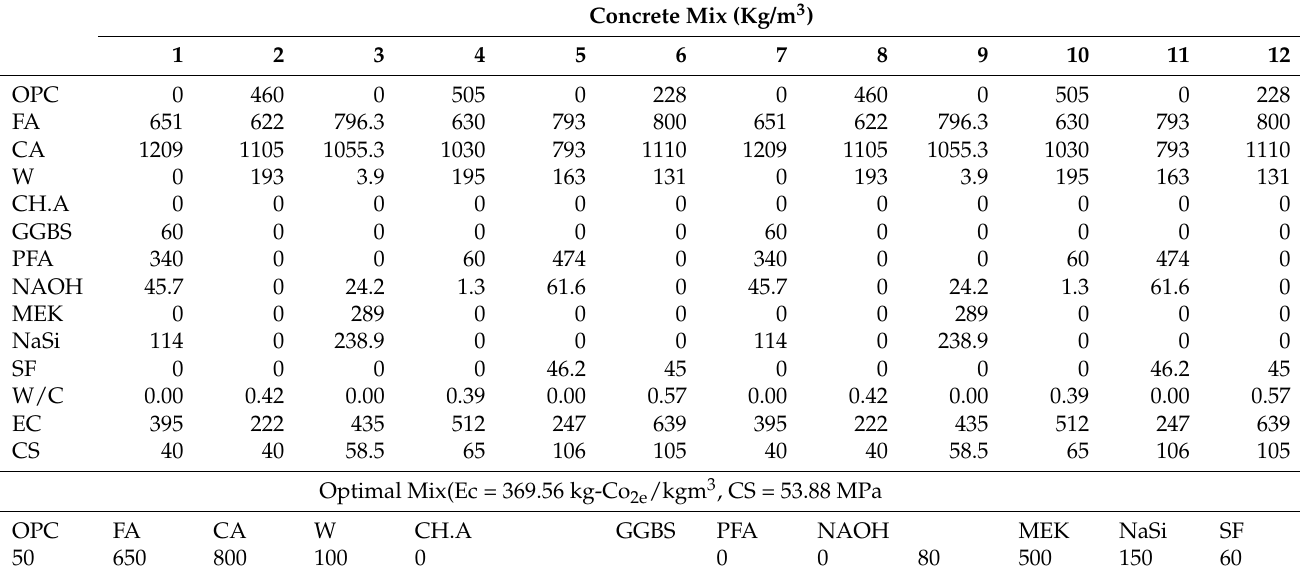
Table 15. Concrete mix optimisation extracted from